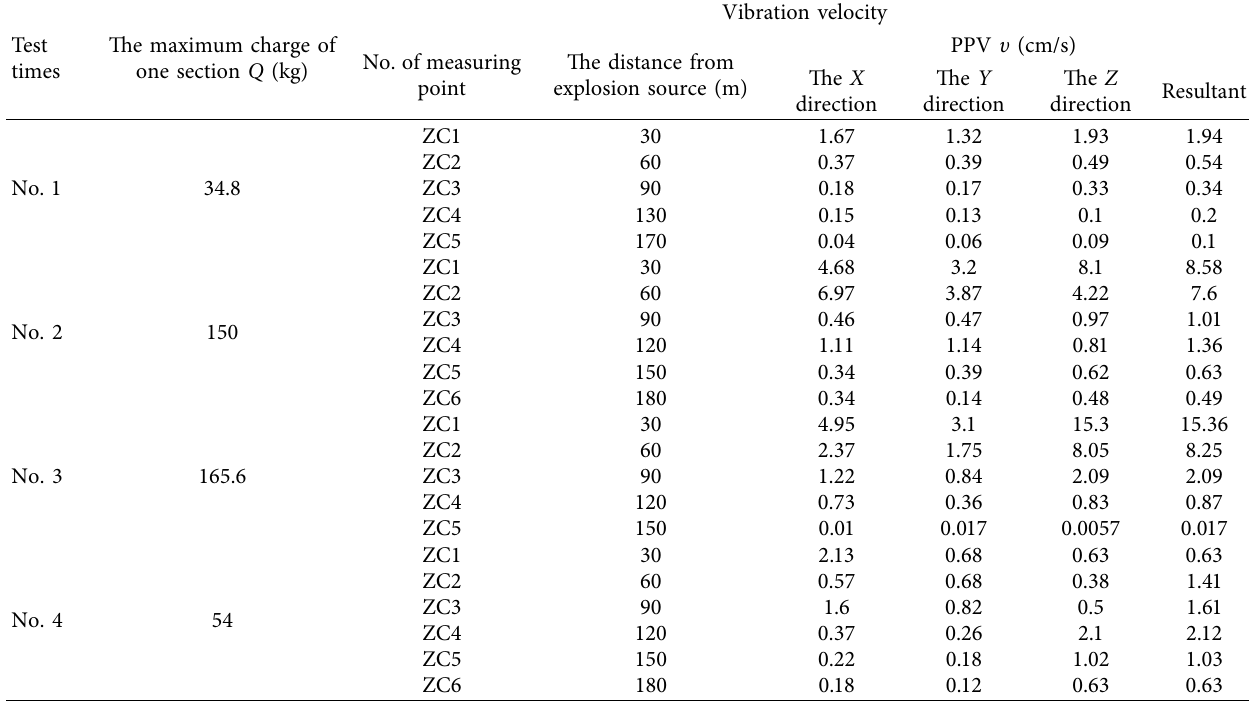
Table 7: Testing results of blasting vibration velocity.